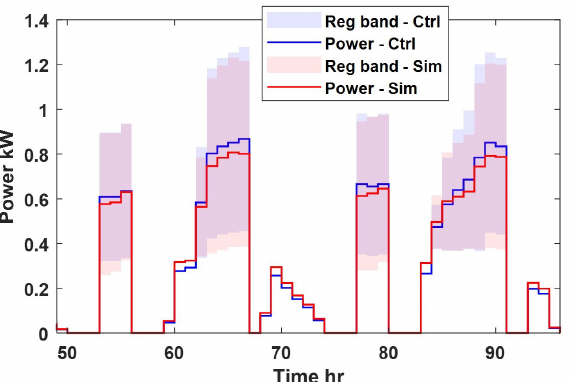
Figure 12. Comparison of control- and simulation-model results using the optimal control